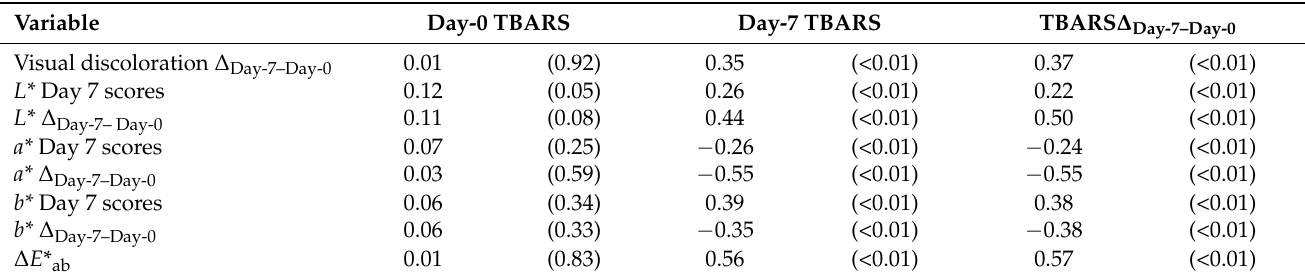
Correlation coefficient between traits is on the right. p -value for correlation coefficients on the left and in brackets indicate the difference from